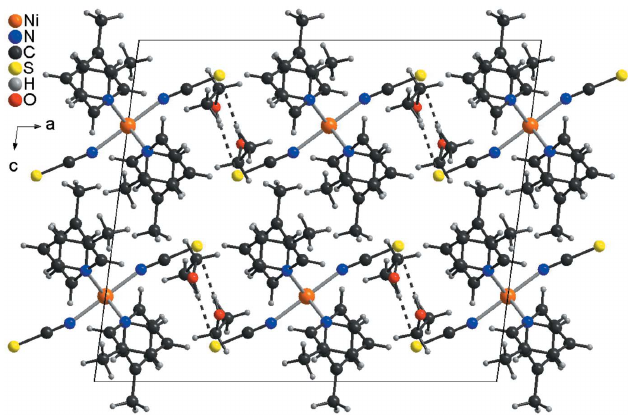
Figure 4 Crystal structure of compound 1 as a representative with view along the crystallographic b -axis and intermolecular O—H (cid:2)(cid:2)(cid:2) S hydrogen bonds shown as dashed lines.